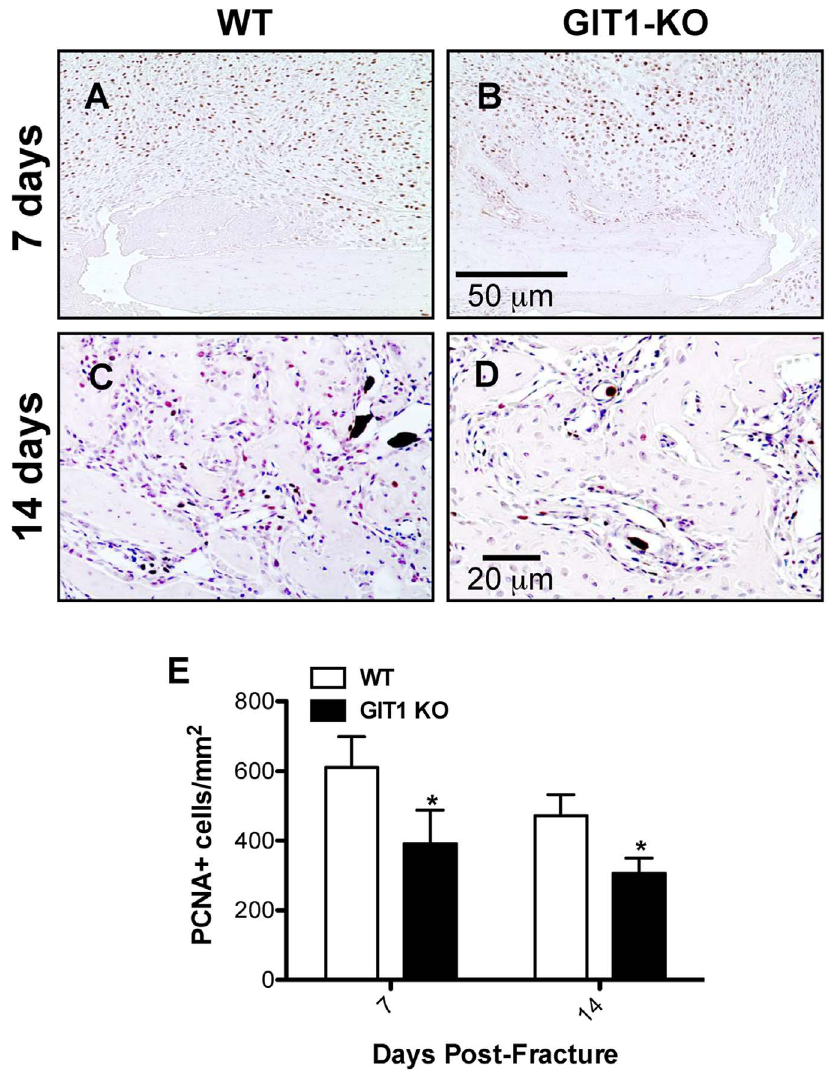
Figure 5. Chondrocyte proliferation is reduced in GIT1 KO mice. Representative PCNA staining is shown at 7 and 14 days post-fracture in WT mice (A and C) and at 7 (B) and 14 days (D) post-fracture in GIT1 KO mice (B and D respectively). Histomorphometry was performed on triplicate sections from multiple mice to quantify the number of PCNA-positive cells per unit callus area (E). The data is presented as mean of the number of PCNA positive cells/mm 2 + / 2 SEM (*p , 0.05,